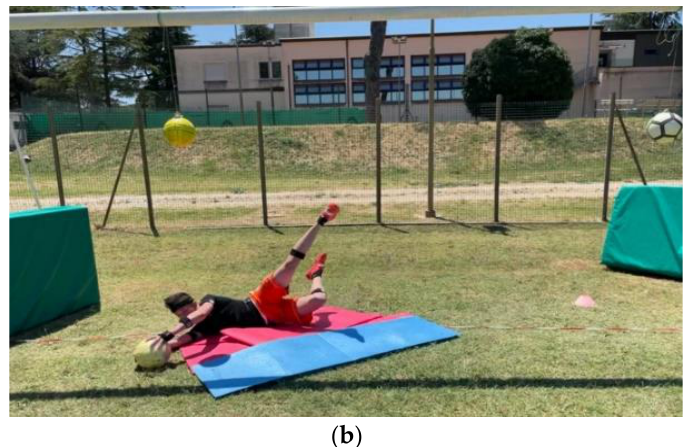
Figure 2. Example of high dive ( a ) and low dive ( b ). The cone was used to standardize the starting position for the save; a rope was used to tie the balls to the crossbar for the high saves; the mattresses were used to avoid injuries to the goalkeepers and damages to the wearable sensor units.